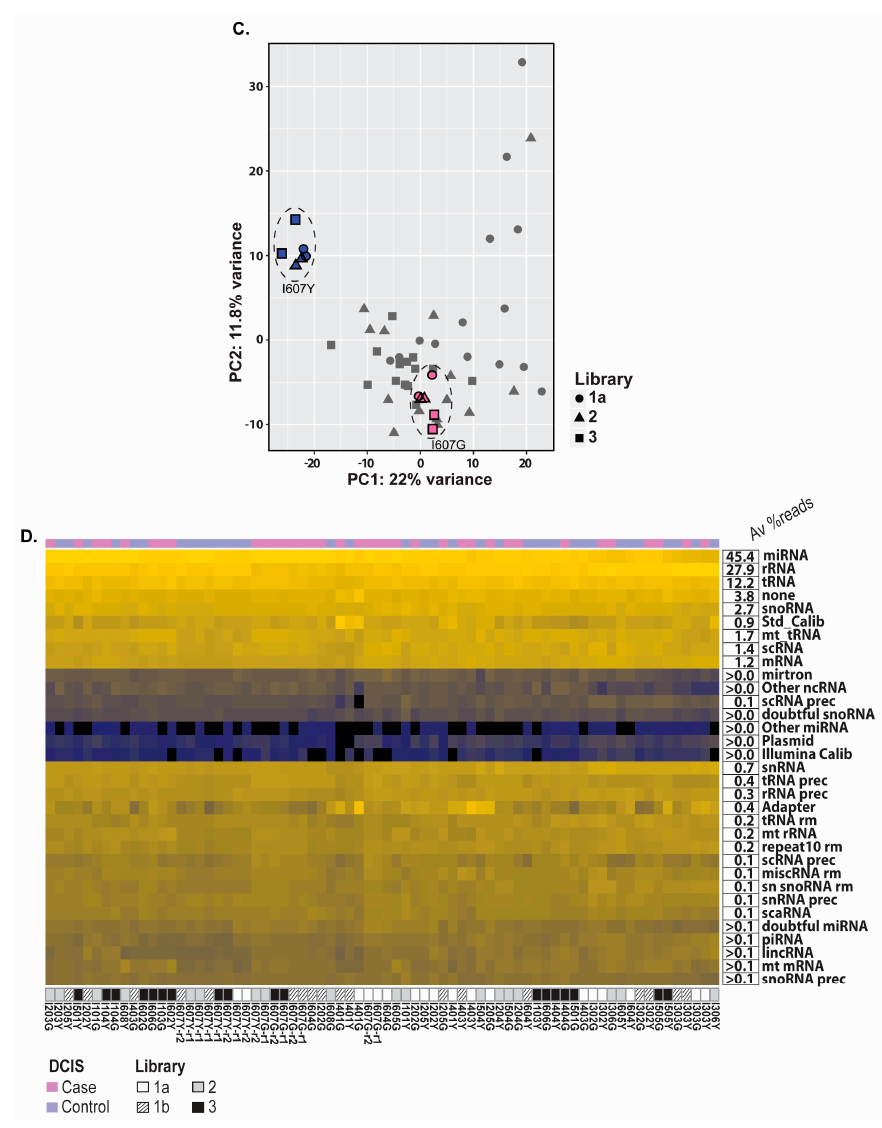
Figure 4. miRNA sequencing of archived DCIS specimens. ( A ) Matched case-control DCIS specimens are distributed into four libraries (black, red, green, blue ovals). Libraries 1a and 1b are duplicates. All libraries contain a control sample pair, analyzed in duplicate (I607G and I607Y). DCIS samples were obtained from six institutions: A (yellow), Kaiser Permanente Colorado (Denver, CO); B (blue), Henry Ford Health System (Detroit, MI); C (orange), Kaiser Permanente Hawaii (Honolulu, HI); D (green), Mashfield Clinic Research Foundation (Marshfield, WI): E (Brown), Kaiser Permanente Northwest (Portland, OR); F (grey), Montefiore Medical Center, Bronx, NY, New York. Libraries 1 (1a and 1b), 2 and 3 were prepared during three consecutive weeks (Weeks 1, 2 and 3); ( B ) Principal component analysis (PCA) plot of the variance between miRNA sequencing data from duplicate analyses (16 plots) in Libraries 1a and 1b. On average, each library included 575 miRNAs; ( C ) PCA plot of the variance between miRNA sequencing data from all libraries (1a (circles), 2 (triangles) and 3 (squares)). All 607Y (blue) and 607G (pink) repeats are circled with a doted line to display tight reproducibility between the different libraries; ( D ) Heat map representation of unsupervised clustering of small-RNA data obtained from 44 DCIS clinical specimens. The average distribution of all small-RNA molecules sequenced in these specimens is provided on the right. Sample ID, library position and barcoded adapters are provided below the heat map.